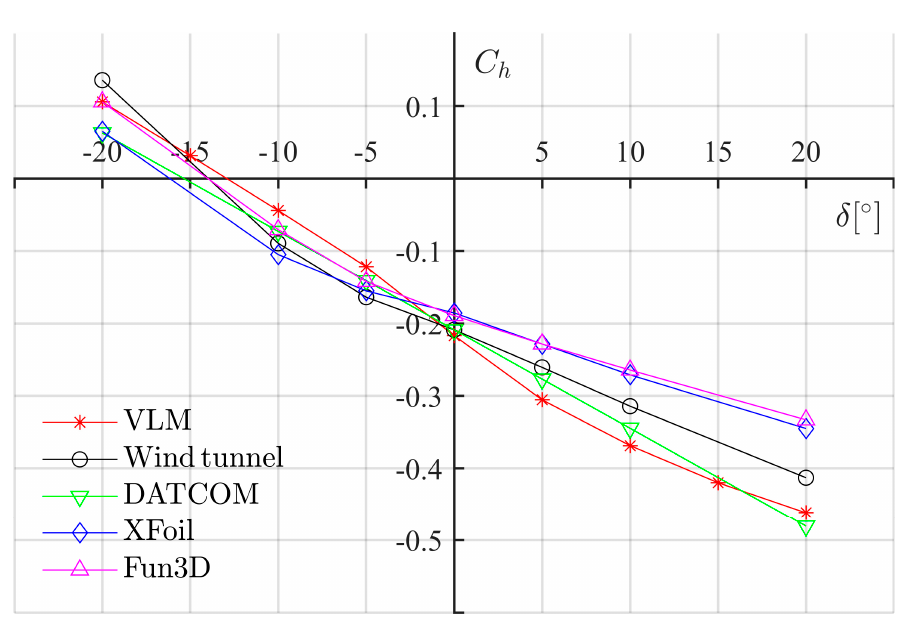
C versus δ for GA(W)-1 at alpha 8°. Figure A5. Figure A5. C h versus δ for GA(W)-1 at alpha 8 ◦ . h Table A5. Comparison of Table A5. Comparison of C h for GA(W)-1 at alpha 8 ◦